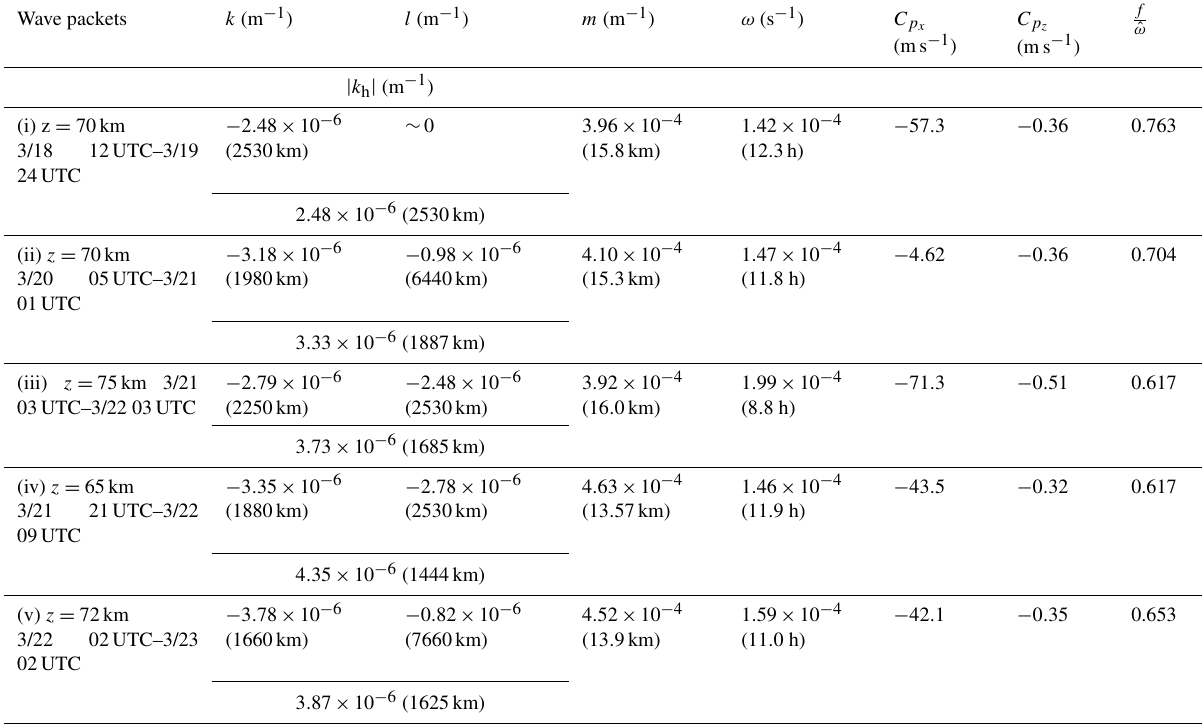
Table 2. The directly estimated wave parameters of simulated packets. Wave